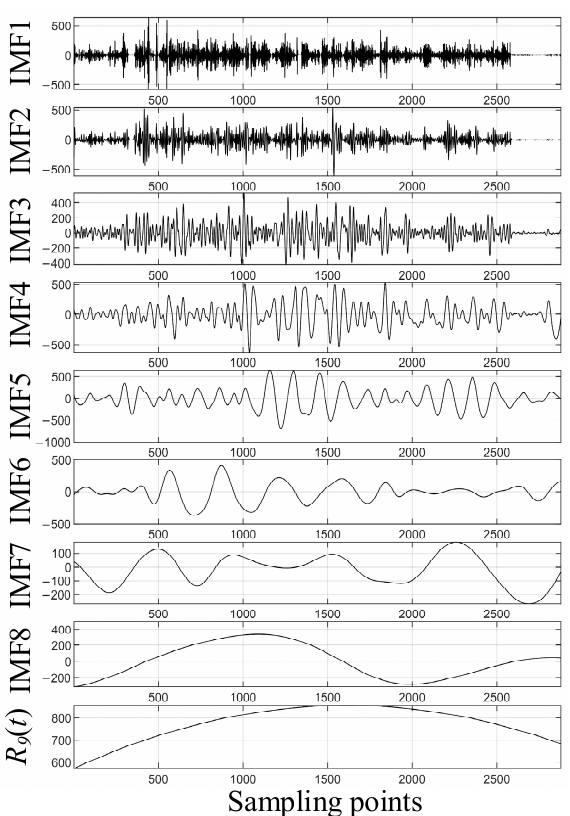
Figure 9. Wind power data CEEMD decomposition results. In this study, the same set of wind power series is decomposed by EEMD and CEEMD, respectively, and the decomposed components are superimposed and reconstructed into a new sequence. As illustrated in Figure 10, the average absolute percentage error MAPE is used to calculate the error between the new sequence and the original sequence, and the reconstruction error of EEMD and CEEMD is finally obtained.